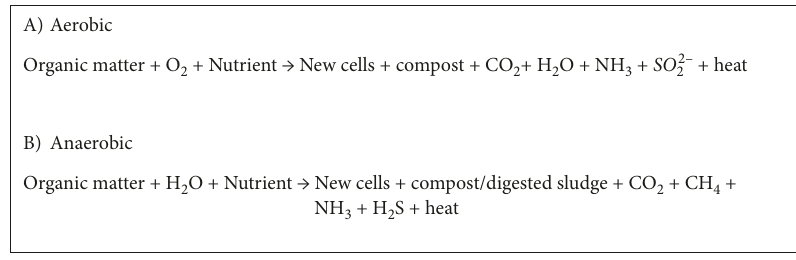
Figure 1: Conversion of organic waste in aerobic composting and anaerobic